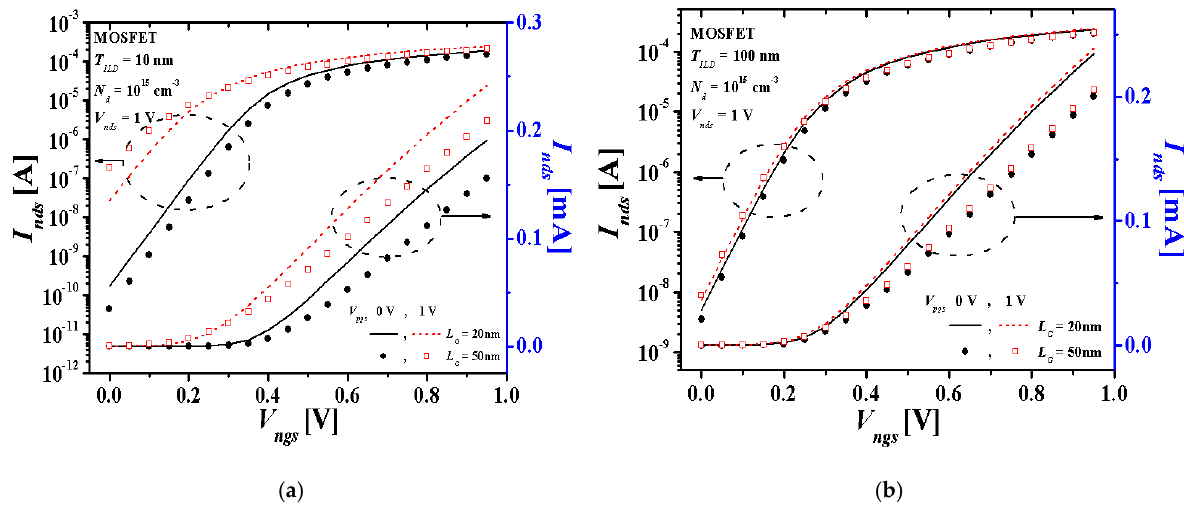
Figure 2. Current-voltage characteristics of the top N-type metal-oxide-semiconductor field-effect transistor (MOSFET). ( a ) I nds - V ngs characteristics at V pgs = 0 (solid lines and filed circles) and 1 V (dotted lines and empty squares) in the case of ILD = 10 nm and ( b ) I nds -V ngs characteristics at V pgs = 0 (solid lines and filled circles) and 1 V (dotted lines and empty squares) in the case of T ILD = 100 nm. The lines and symbols denote L G = 20 and 50 nm, respectively. We use W/L = 0.2/0.03 μ m.